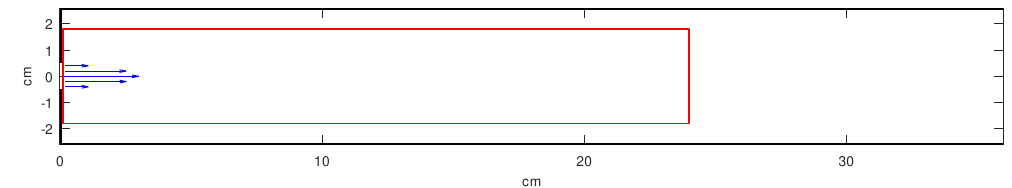
Figure 1. Longitudinal section of the computational domain. The domain dimensions are 36 × 5.2 × 5.2 cm 3 . The inlet is on the left, and the outlet is on the right. The pipe walls are shown via thick black lines, so that both the inlet and outlet are visible. The boundary of the Fourier spectrum measurement region is shown in red. This region is a box of 24 cm in length and 3.6 × 3.6 cm 2 in